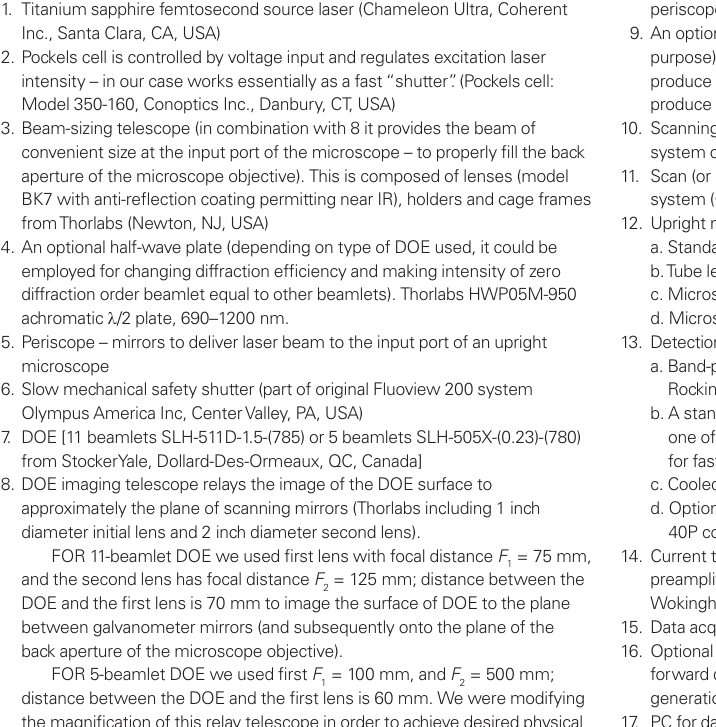
FIGURE 1 | Optical path and microscope design. (B) Detailed diagram of all elements of our optical and image acquisition